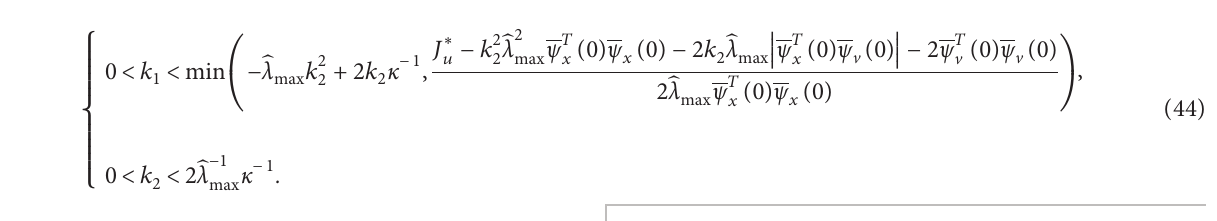
Figure 1: Communication topology G for the leaderless